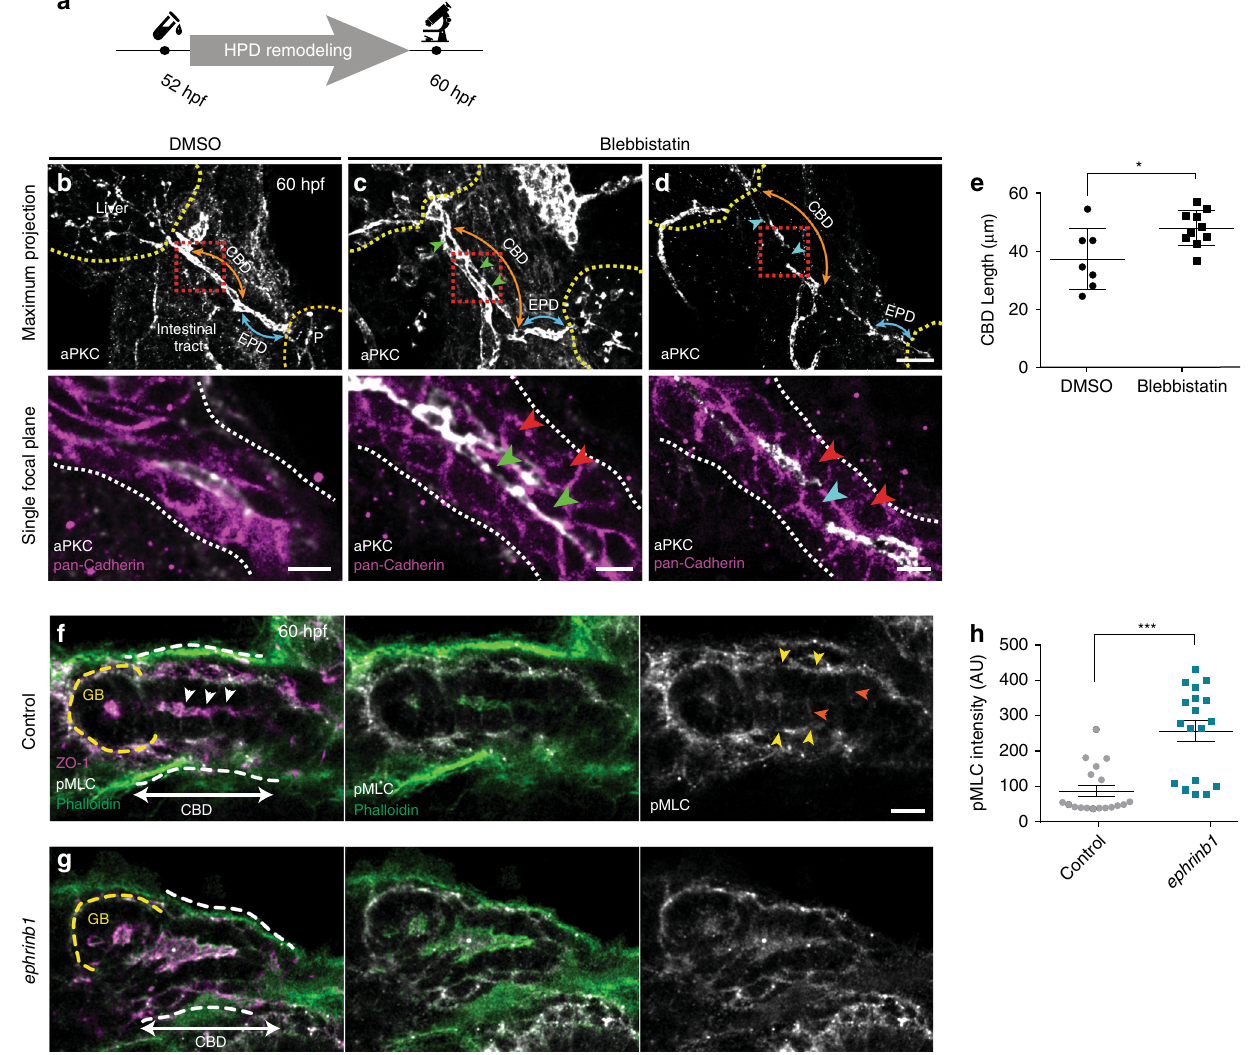
Fig. 4 HPD differentiation requires EphrinB1-controlled actomyosin contractility. a Experimental scheme for 65 μ M blebbistatin incubation during HPD remodeling from 52 – 60 hpf. b – d Blebbistatin-treated embryos show two types of EHB epithelial defects: c extensive luminal loops (45.5%, n = 11, N = 2) and d gaps in the emerging apical lumen (45.5%, n = 11, N = 2; and 9% wild-type like). The nascent EPD lumen is mostly resolved, consistent with the treatment window; scale bars = 15 μ m. PanCadherin staining (magenta) of magni fi ed views of CBD (red dashed box) shows rounder epithelial cells (red arrowheads), a multi-layered con fi guration with loops and cells exhibiting extended apical domains (green arrowheads) or gaps and cells with multiple apical domains (blue arrowhead) in treated embryos compared to controls; scale bars = 5 μ m. e Quanti fi cation of CBD length shows signi fi cant increase upon blebbistatin treatment compared to controls. f , g Actin, pMLC and ZO-1 localize apically (white arrowheads) in the forming CBD; whether pMLC is at the apical membrane and/or the junctional belt cannot be distinguished. pMLC is at the duct mesoderm border (yellow arrowheads) and lower levels at the lateral membrane (orange arrowheads) 60 hpf; scale bars = 5 μ m. h Quanti fi cation of apical pMLC expression in CBD cells of 60 hpf control ( n = 3) and ephrinb1 embryos (n = 3). For quanti fi cation strategy see Supplementary Fig. 5. Statistical test: e , h = Student ’ s t -test. Error bars show SEM; * p < 0,05, *** p < 0,001. Source data are provided as a Source Data fi